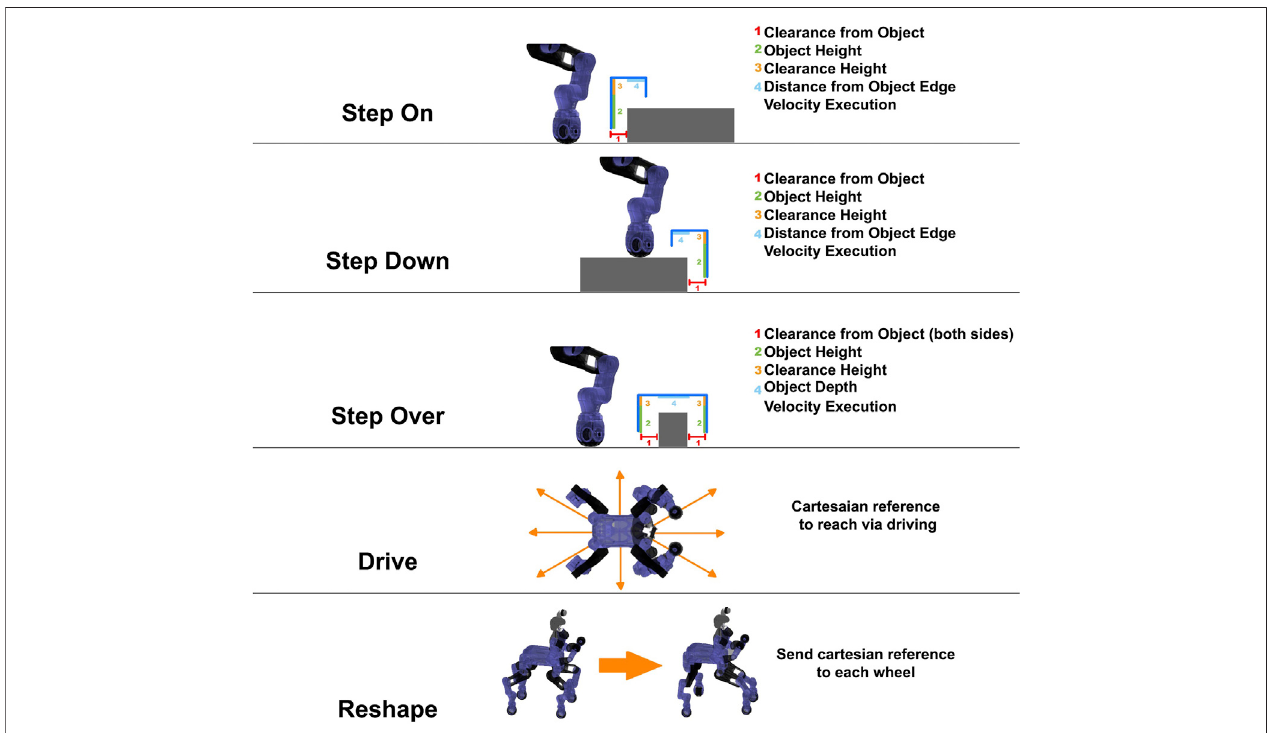
FIGURE4| Graphicalrepresentationofthetemplateprimitivesandtheirparameters.Ontherightsidewecanseethelistofalltheparametersthatareconsideredin the de fi nition of the primitive. In more details, for the stepping actions, the parameters allows to change at run-time the trajectory of the end effector based on the perceived